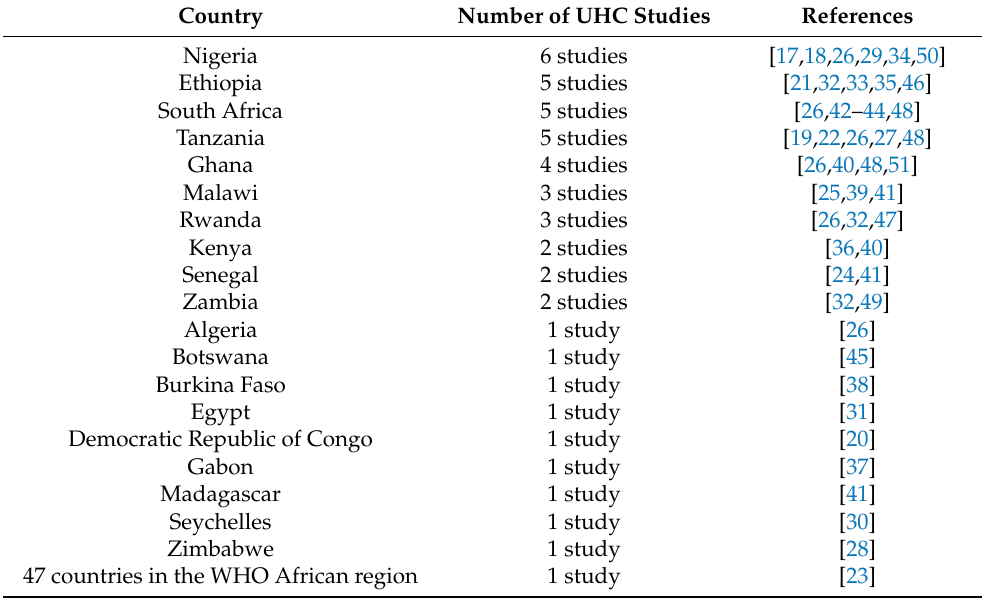
Table 4. Number of UHC studies conducted in Africa.